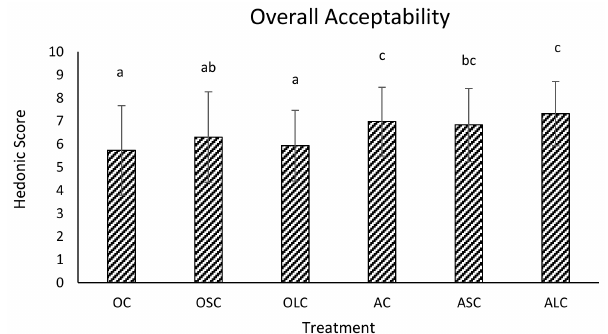
Figure 6. The hedonic scores (Mean ± SD) on the overall acceptability of all 6 fruit juice samples from the panellists. The same letter above each bar graph indicates that there was no significant difference ( p > 0.05), while bar graphs with different letters indicate that there was a significant difference ( p < 0.05) according to Tukey’s studentized range test. OC, OSC, OLC (orange juice control, short chain and long chain inulin